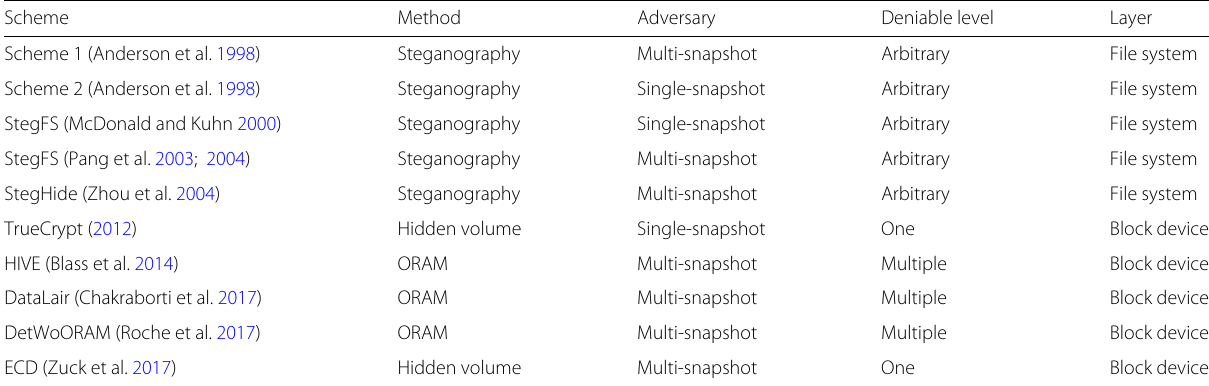
Table 1 Summary of PDE systems for desktop computers